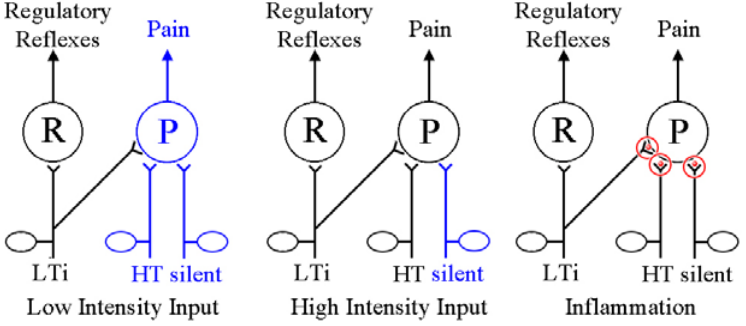
FIGURE 3 . A schematic representation of the hypothesized roles for different visceral receptors. Visceral afferents are shown to activate two central mechanisms, one responsible for regulatory and nonpainful responses (R), and the other for pain experience (P). Normal regulatory activity is shown to the left. Low-threshold input is insufficient to activate the pain mechanism, which is shown as deactivated (blue). Transient, high-intensity input activates both the low- and high-threshold afferents triggering pain sensation. Prolonged stimulation, such as inflammation, also activates the so-called silent nociceptors and sensitizes the central inputs of both high- and low-threshold afferents (shown in red). Adapted from Cervero and Janig[13].